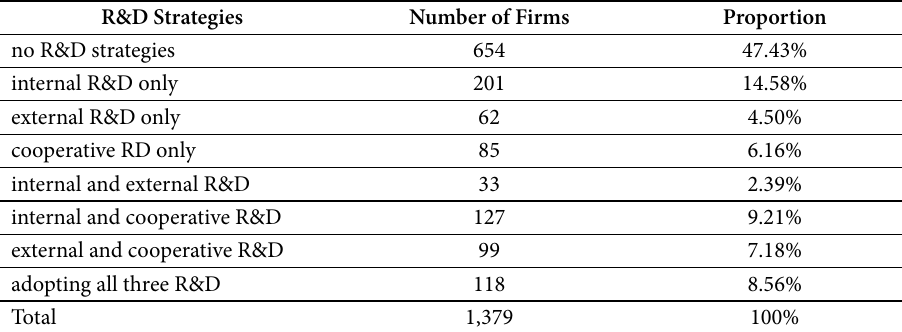
Table 1. Frequency of R&D